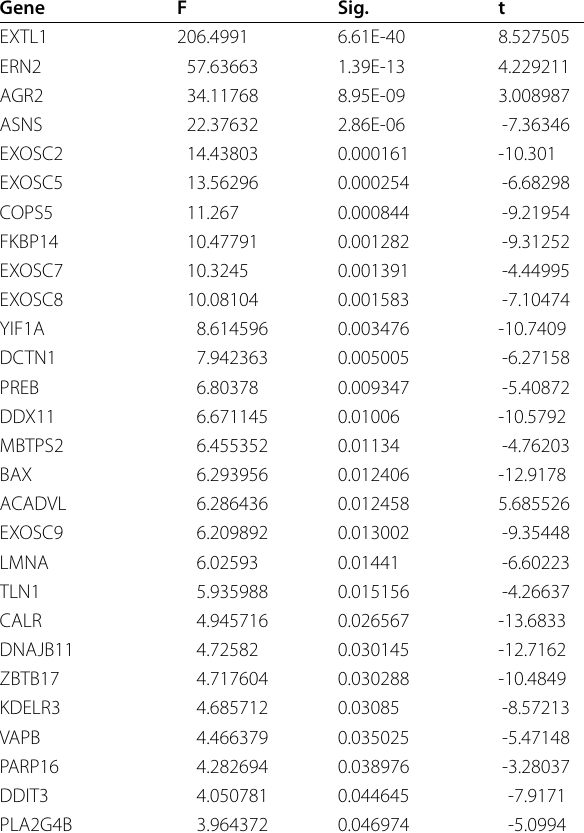
Table 3 The difference of the expression levels of 98 ERS-related genes between normal and tumor samples Gene F